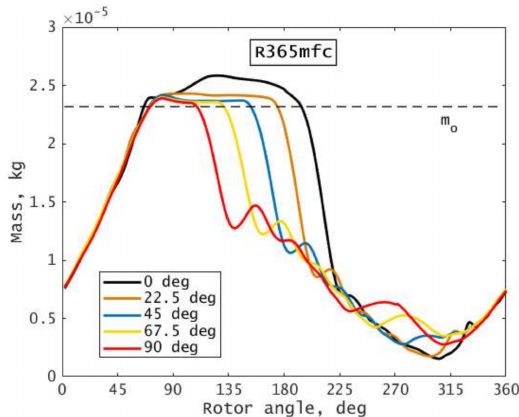
Figure 11. Mass of the working fluid in the working chamber of the expander versus rotor crank angle and different outlet port